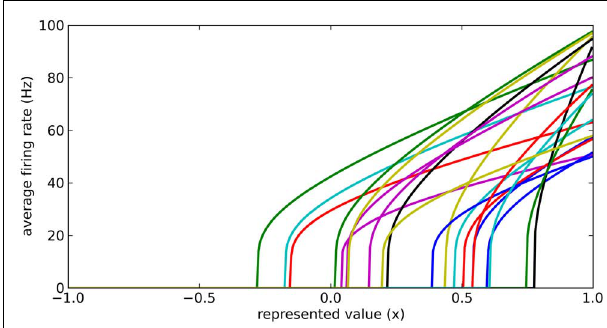
FIGURE 2 |Typical randomly generated tuning curves for a population of 20 neurons. Each neuron has a different gain and background current, resulting in a different firing rate when representing the same value x